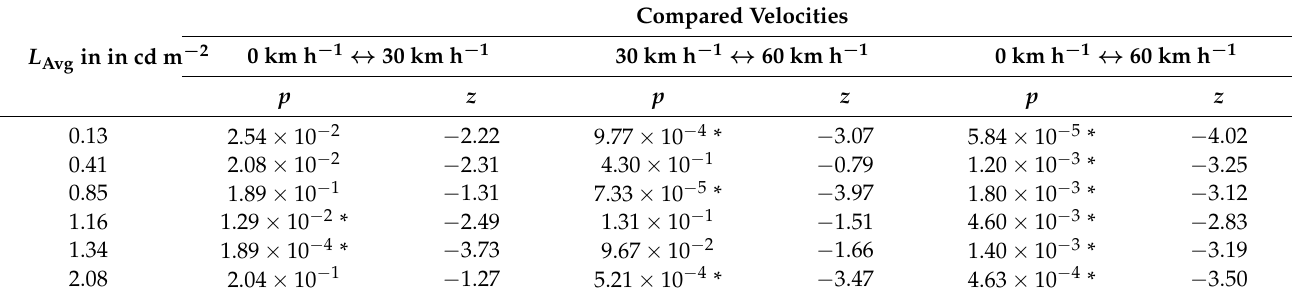
Table 3. Test statistics for pairwise comparison of the three velocities at the investigated luminance levels. p -values smaller than the significance level ( α Bonferroni = 0.0167) indicate luminance levels at which a significant difference between the two compared velocities exists (marked with